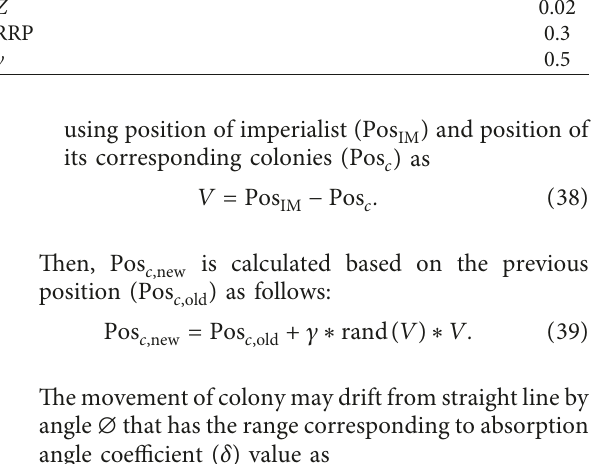
Parameter Value Country